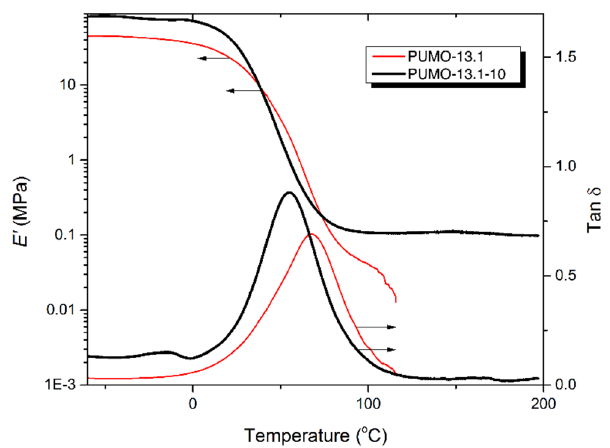
Figure 7. DMA results for PUMO-13.1 e PUMO-13.1-10.